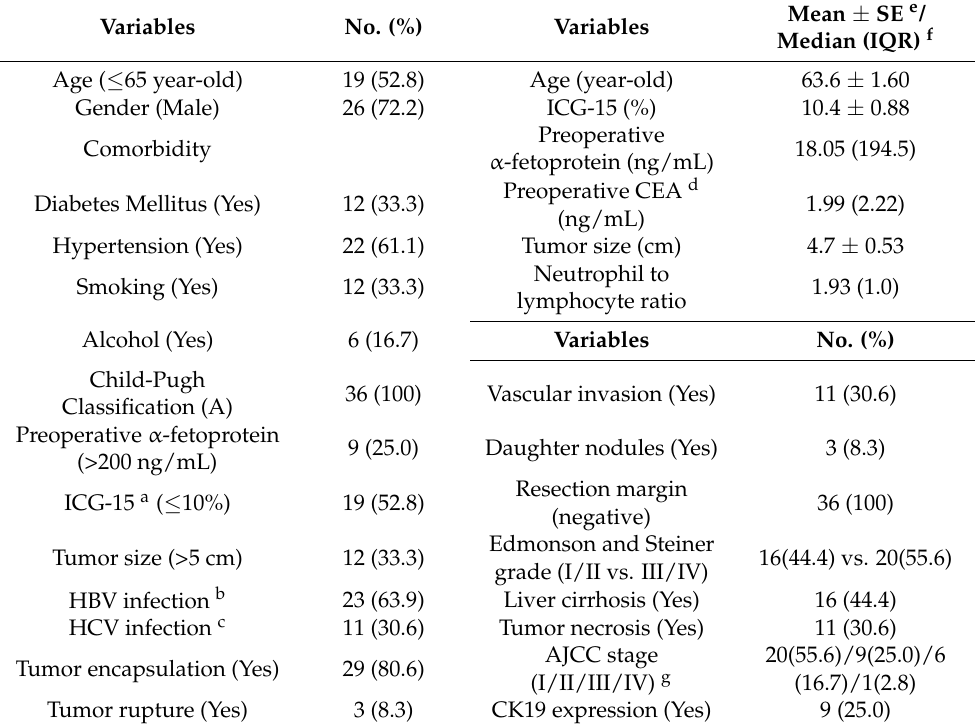
Table 1. Demographic data of patients with hepatocellular carcinoma undergoing hepatectomy (n = 36).